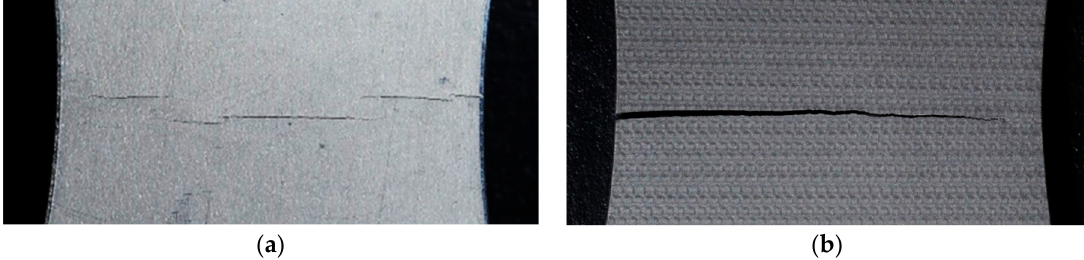
Figure 1. Aspect of a fractured fatigue specimen of stainless steel. ( a ) Non-peened specimen ( σ a = 301 MPa, N f = 7.8 × 10 5 ); ( b ) specimen treated by laser cavitation peening ( σ a = 308 MPa, N f = 4.8 × 10 6 ).